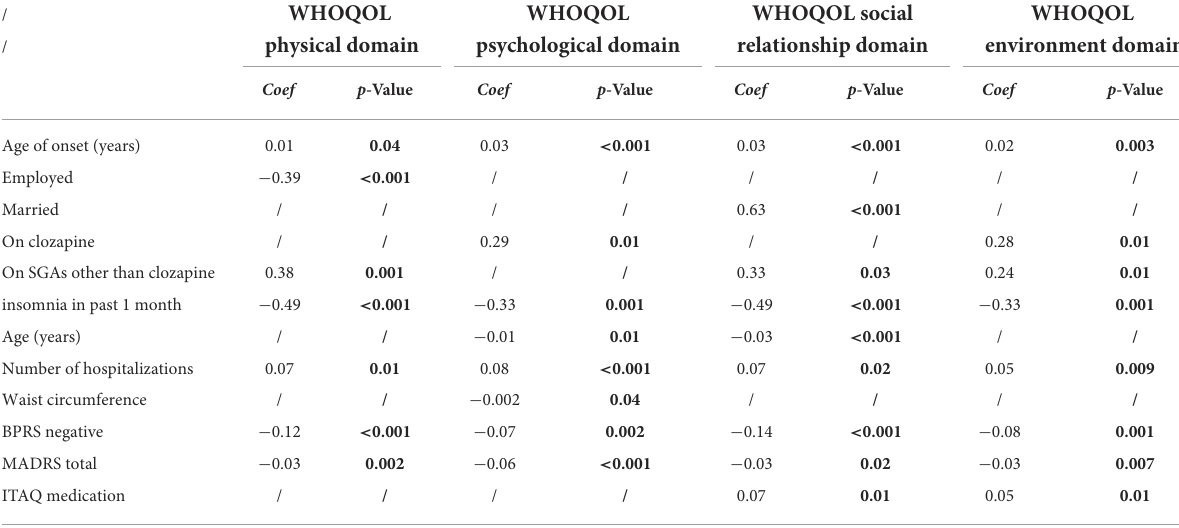
TABLE 8 Summary of generalized estimating equation (GEE)